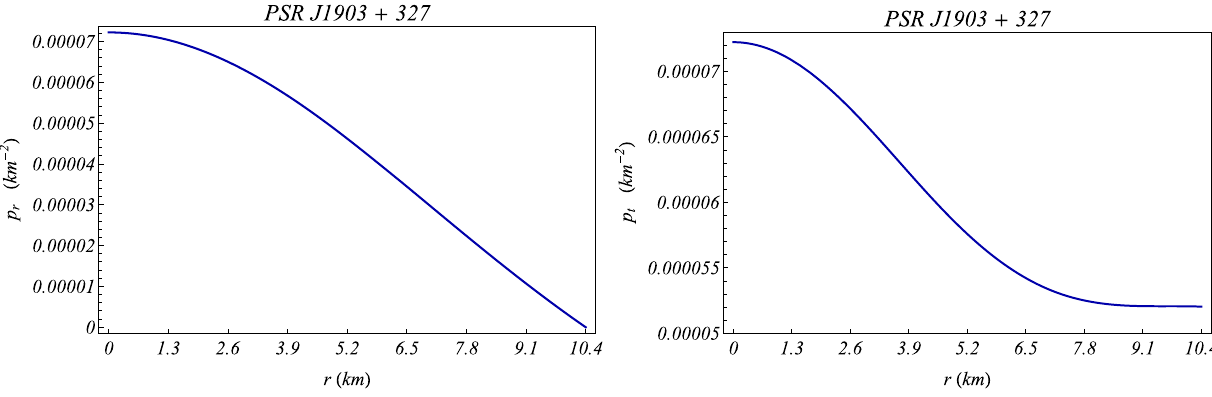
Fig. 2 The radial pressure p r (left) and transverse pressure p t (right) are plotted against r inside the stellar interior for the compact star PSR J1903+327